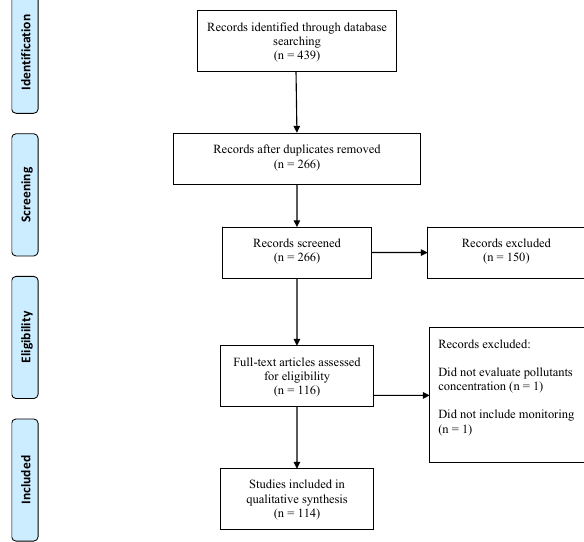
Figure 1. Systematic review flowchart (Adapted from Moher et al. [11]).